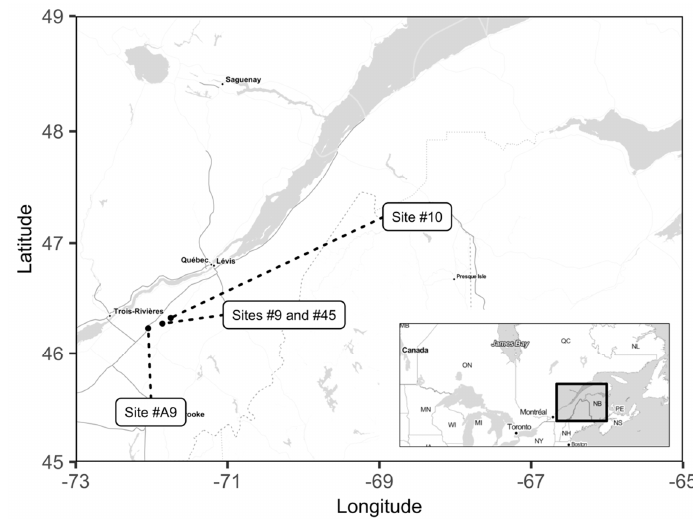
Figure 1. Map of the cranberry experimental sites in Southern Quebec, Canada.